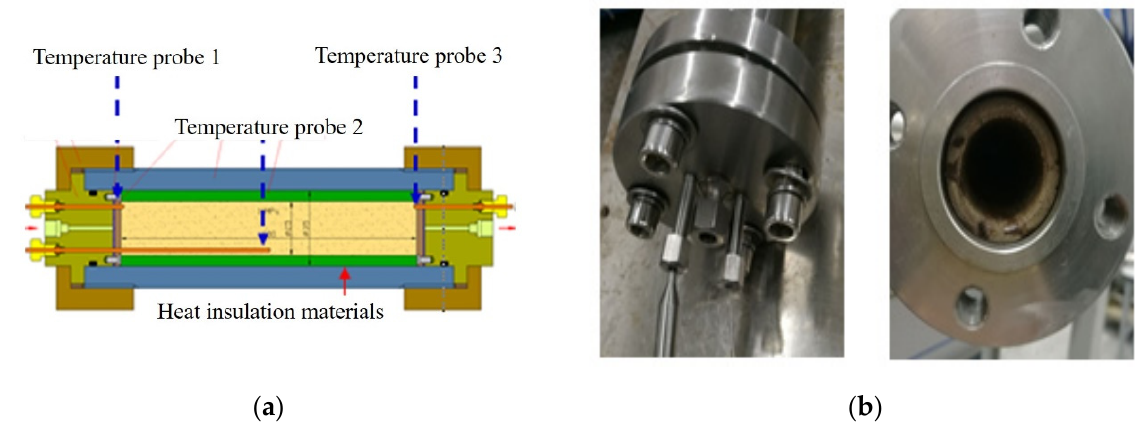
Figure 3. The sandpack with three temperature probes: ( a ) is a schematic diagram and ( b ) is a real picture.